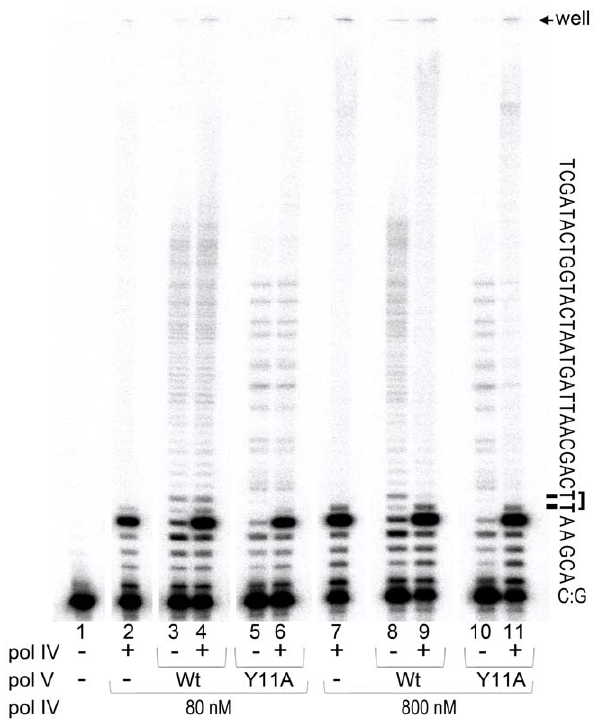
Figure 3. Invitro translesion synthesis past a TT-CPD lesion catalyzed by mixtures of pol IV and pol V. Translesion DNA synthesis was performed using a circular DNA template with a running- start primer with its 3 9 end located 5 bases before the 3 9 T of the CPD. Primer extension reactions catalyzed by pol IV (80 nM, lane 1 or 800 nM, lane 6), wild-type pol V (80 nM, lanes 2 and 7), pol V (UmuC_Y11A) (60 nM, lanes 4 and 9), or a combination of pol IV (80 nM, lane 3 and 5 or 800 nM, lane 8 and 10) with either wild-type (80 nM, lanes 3 and 8) or polV (UmuC_Y11A) (60 nM, lanes 5 and 10) were performed for 30 sec as described in the Methods section. Part of the template sequence and position of the gel wells and a CPD lesion are indicated to the right of the gel panel. As clearly observed, when present in a 10-fold excess (similar to SOS induced conditions), pol IV inhibits TLS catalyzed by pol